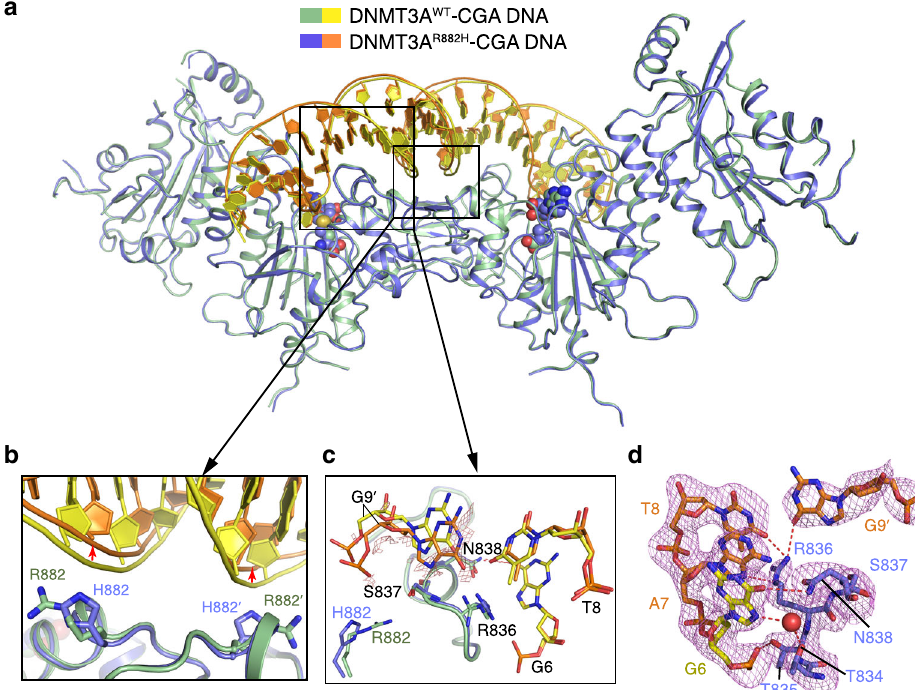
Fig. 3 Structural comparison of the DNMT3A WT – CGA and DNMT3A R882H – CGA complexes. a Structural superposition of the DNMT3A WT – CGA and DNMT3A R882H – CGA complexes. b Structural comparison of the RD interface between the DNMT3A WT – CGA and DNMT3A R882H – CGA complexes. c Structural comparison of the TRD loop and its interactions with CpG guanine (G6) and R882 in the DNMT3A WT – CGA and DNMT3A R882H – CGA complexes. The hydrogen-bonding interactions are indicated by dashed lines. The conformational difference of G9 ′ is validated by the Fo – Fo difference map (salmon) between the two complexes, contoured at 1.0 sigma level. d Close-up views of the DNA interactions of the TRD loop in the DNMT3A R882H – CGA complex, with the Fo – Fc omit map (violet) contoured at 2.0 sigma level. The water molecule is shown as a red